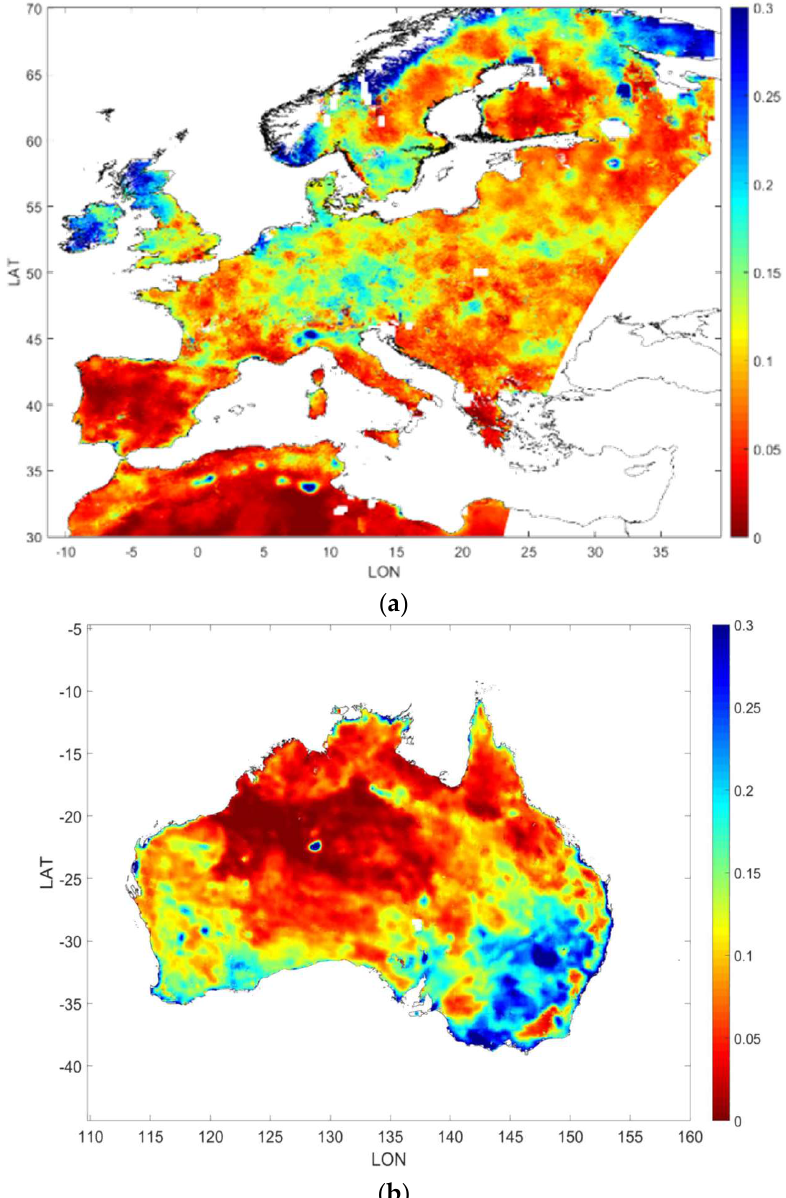
Figure 5. Sample 1 km L4 downscaled average SM maps over ( a ) Europe (6/2011), and ( b ) Australia